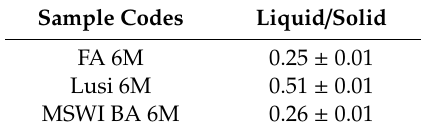
Figure 1. Illustration of the granulation process. Table 1. Liquid/solid weight ratio of the lightweight aggregate (LWA).